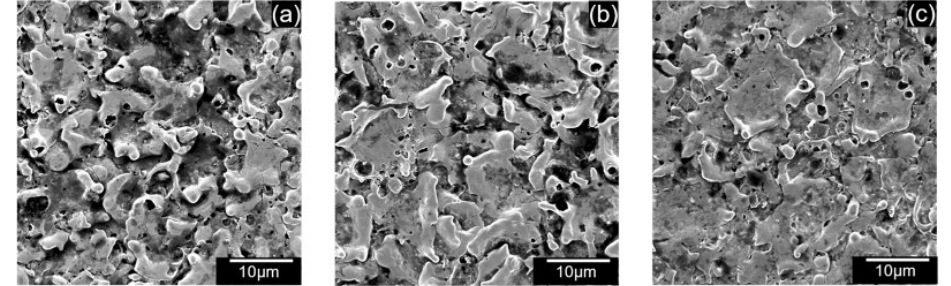
Figure 21. SEM of machined surface using 0.5 g/L silicon at ( a ) 90 V ( b ) 100 V, ( c ) 110 V.